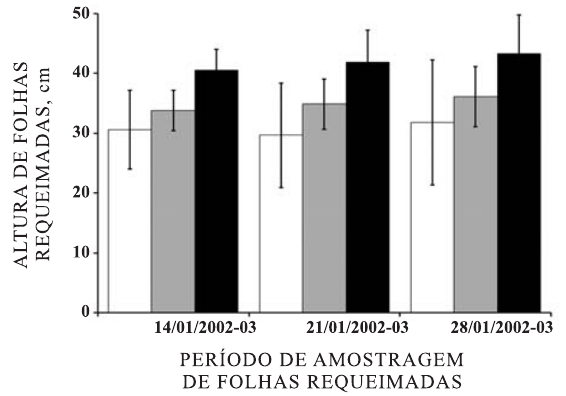
Figura 4. Altura de requeima, em razão da interação quantidade de palha x genótipos, em um Latossolo Vermelho distrófico após seis anos de plantio direto (média dos 13 genótipos) em três épocas de amostragem, a partir do final do estádio de florescimento pleno. As demais datas foram durante o estádio de enchimento de grãos. As barras indicam o desvio-padrão em relação à média. 0 Mg ha -1 ; 5 Mg ha -1 ; 10 Mg ha -1 . Média dos dois anos agrícolas (2001/02 e 2002/